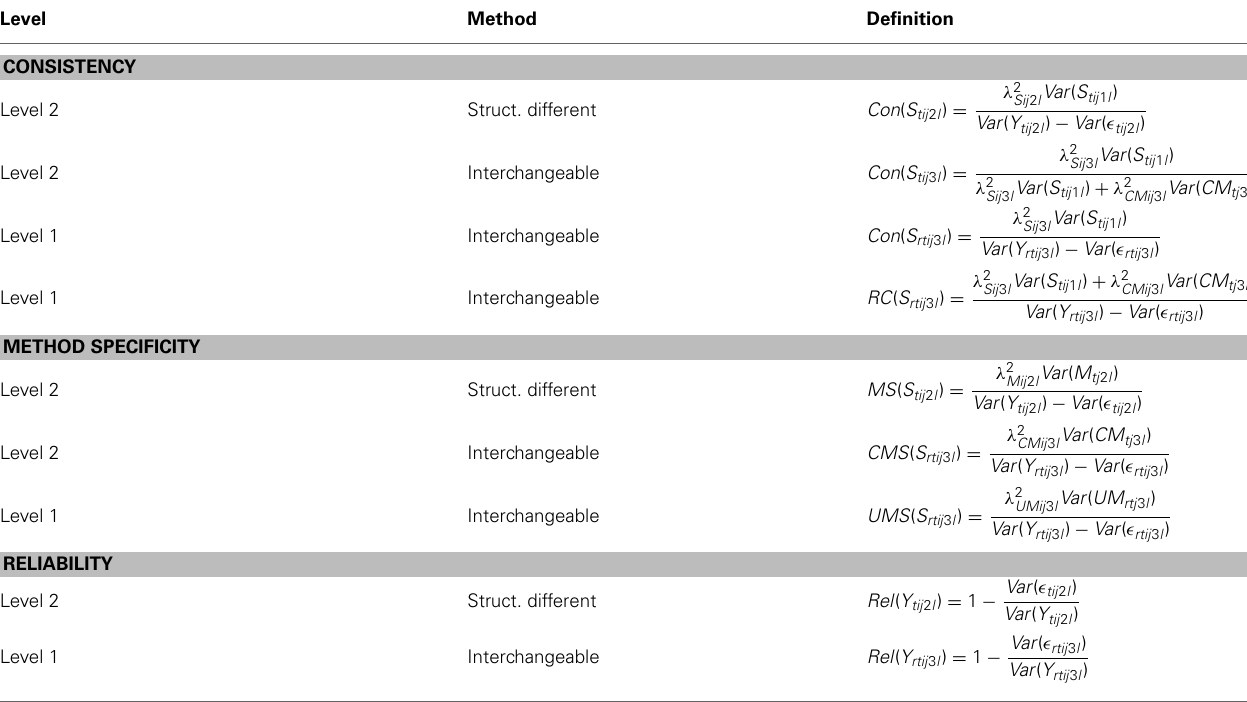
Table 1 | Variance components of the non-reference method indicators in LS-COM